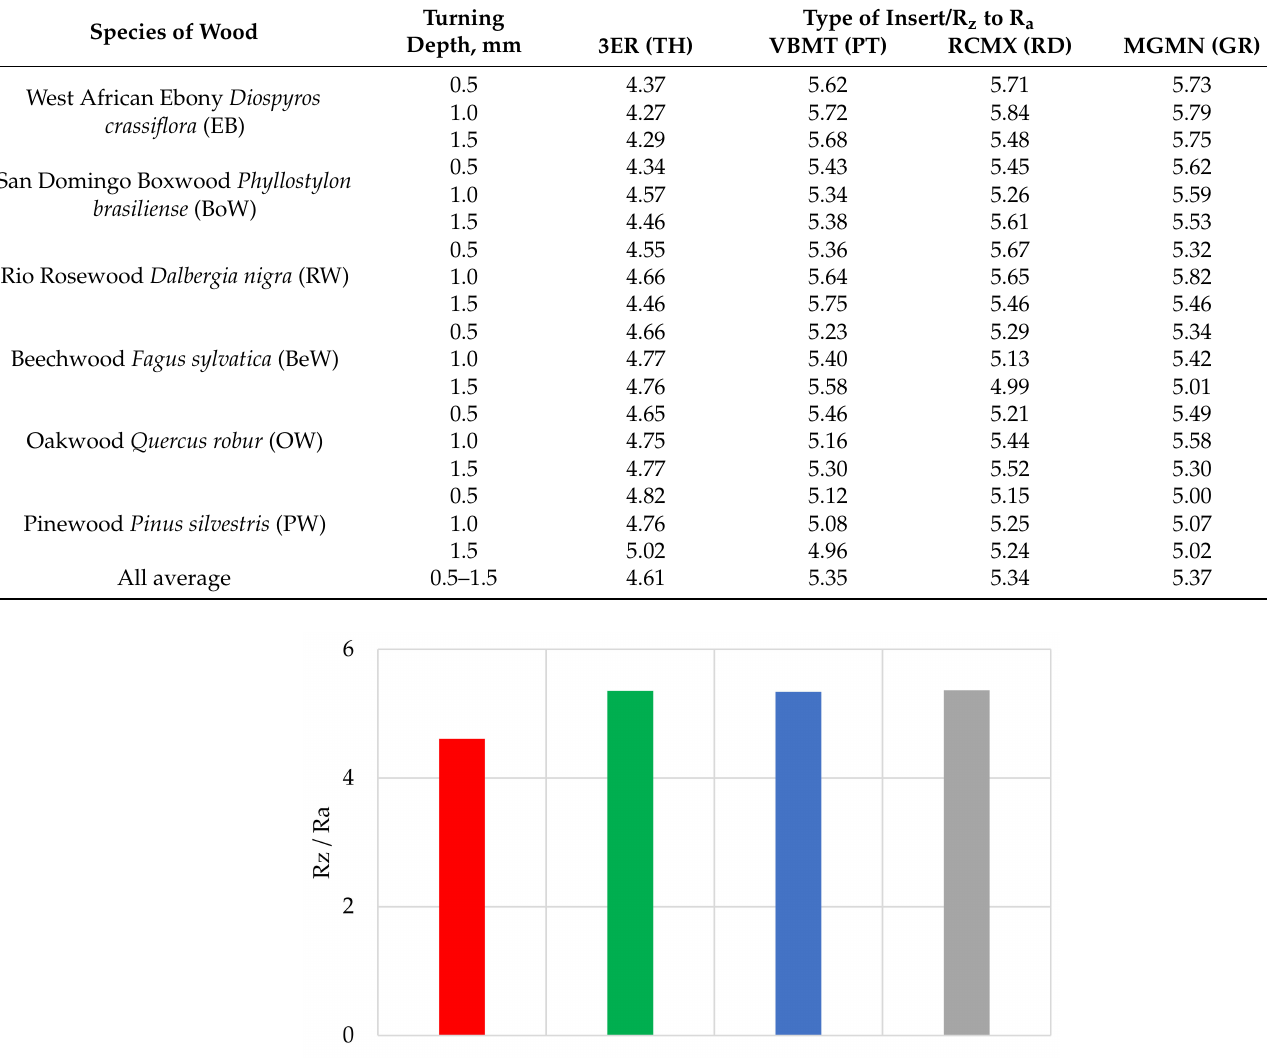
Table 4. The quotients R z to R a obtained in the tests depend on the type of insert and wood species.